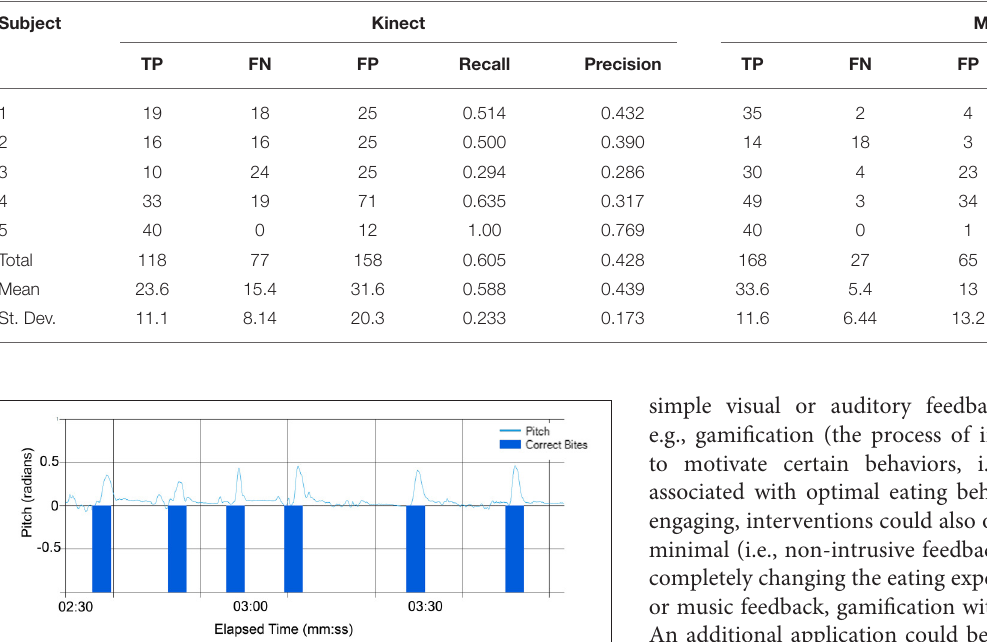
FIGURE 5 | Graph of pitch readings along with vertical markers of manually verified bite